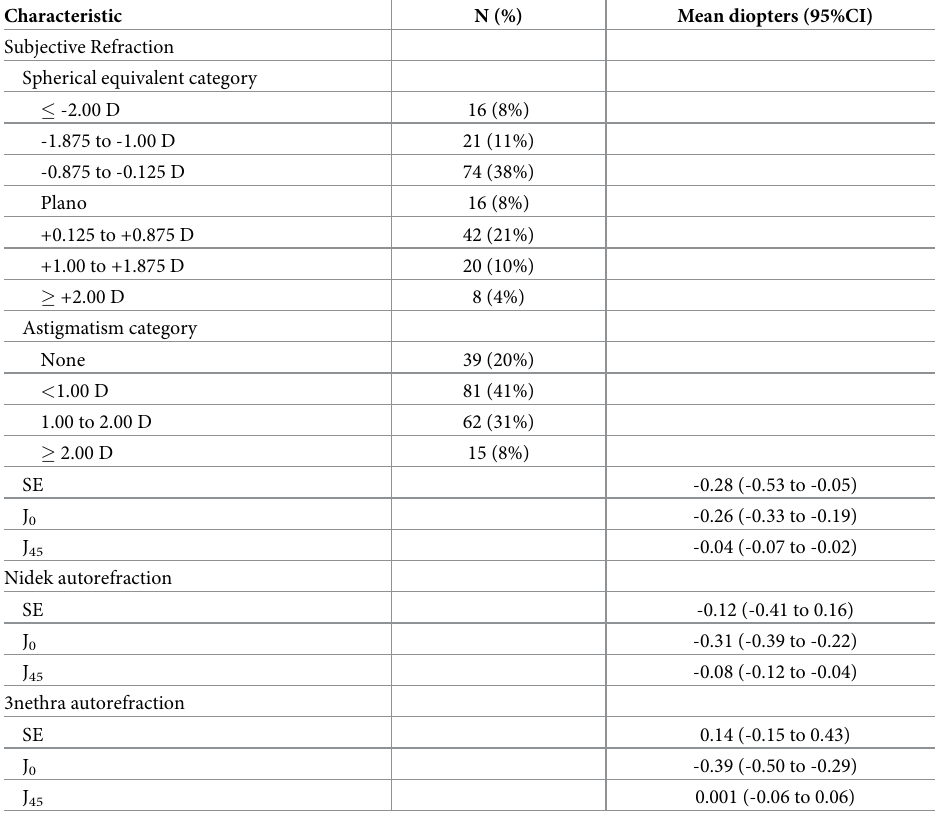
Table 1. Refractive characteristics of 197 study